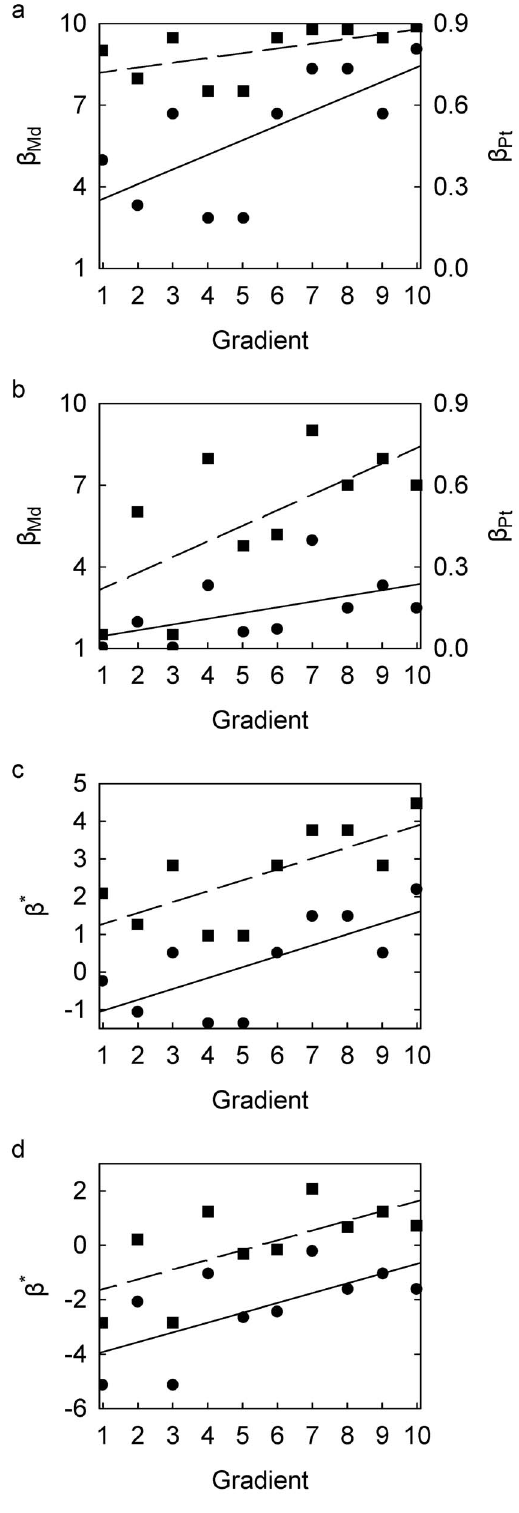
Figure 2. Scatterplots of beta-diversity indices against hypo- thetical ecological gradient. (a) Scenario B: b Md (circles, left axis) and b Pt (squares, right axis); linear regression trends, for b Md y ~ 0 : 54x z 3 : 02 ( p ~ 0 : 026 ), for b Pt y ~ 0 : 02x z 0 : 70 ( p ~ 0 : 097 ). (b) Scenario C: b Md (circles, left axis) and b Pt (squares, right axis); linear regression trends, for b Md y ~ 0 : 21x z 1 : 25 ( p ~ 0 : 121 ), for b Pt y ~ 0 : 06x z 1 : 64 ( p ~ 0 : 036 ). (c) Scenario B: b * Md (circles) and b * Pt (squares); linear regression trends,